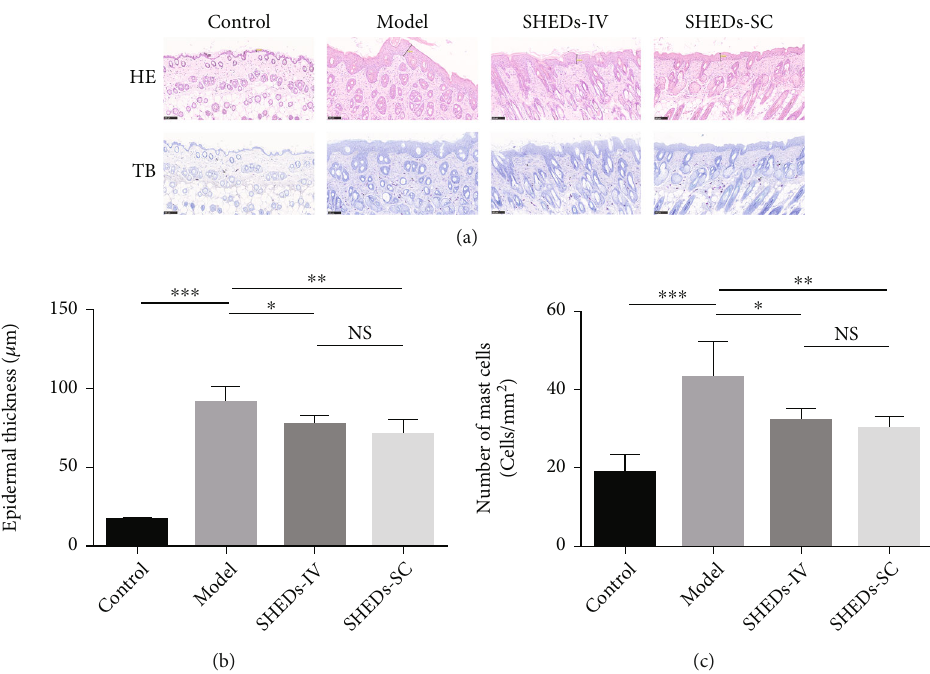
Figure 2: E ff ect of SHEDs on cutaneous histopathological observations. (a) Representative histologic fi ndings of cutaneous tissue sections stained with hematoxylin and eosin (HE) or toluidine blue (TB) (magni fi cation 200x; scale bar = 100 μ m). (b) The thicknesses of the epidermis in BALB/c mice of each group. (c) The number of in fi ltrated mast cells in 1 mm 2 of skin lesion in BALB/c mice of each group. All the data are expressed as mean ± SD ( n = 6 ). Three repeated times of each experiment were conducted.